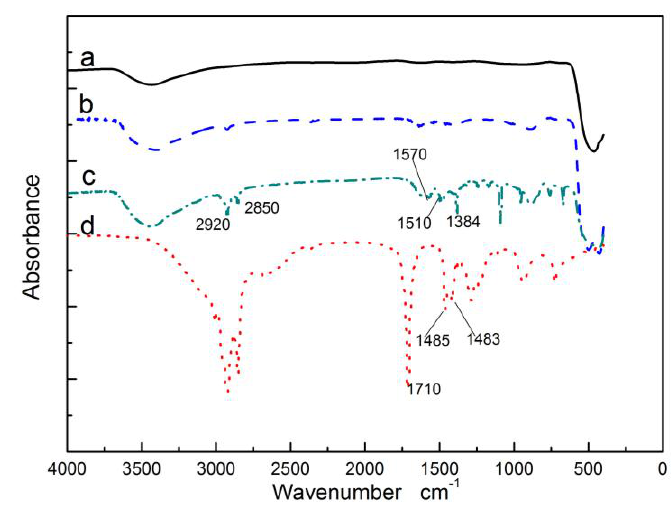
Figure 1. FTIR spectrum of nano-ZnO and the modified nano-ZnO, bare ZnO (a), OA–APS–ZnO (b),